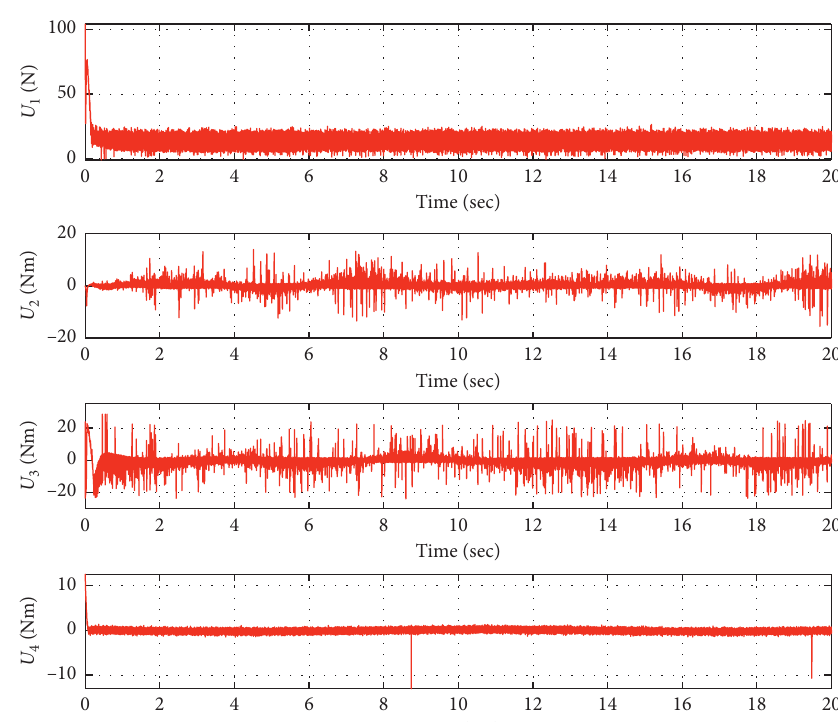
Figure 10: Control